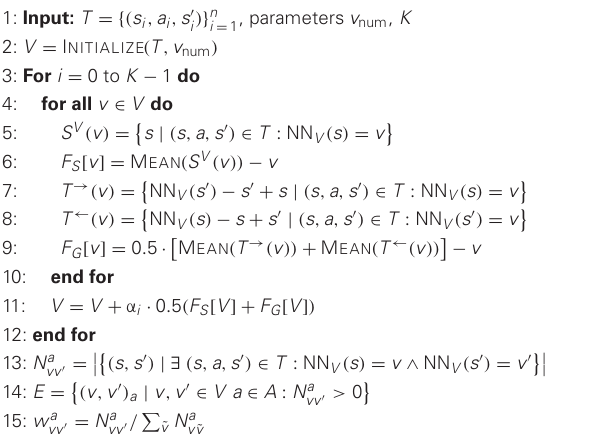
FIGE is summarized in Algorithm 1 : the set of graph nodes V with cardinality | V | = v num is initialized such that it covers the